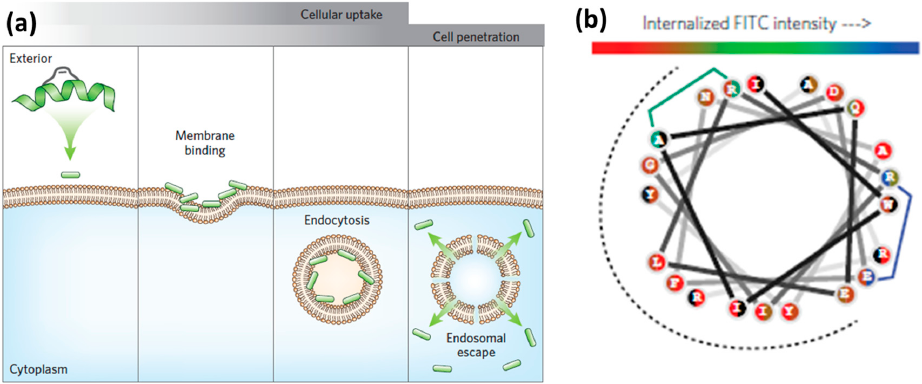
Figure 10. Schematic representation of ( a ) stapled CPP internalization by endocytosis followed by endosomal escape, taken with permission from reference [148], (Copyright © 2016, Nature Publishing Group) and; ( b ) wheel depiction of a stapled helix with the hydrophobic face indicated by the dotted surface and the two distinct staples indicated with blue and green lines, taken with permission from reference [146], (Copyright © 2016, Nature Publishing Group).